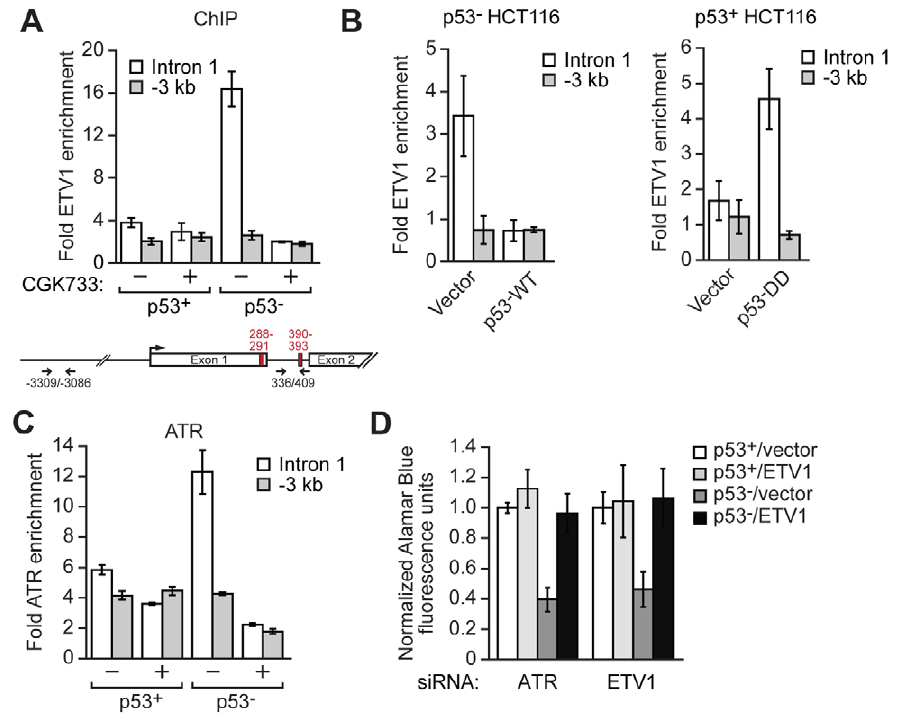
Figure 7. ATR and ETV1 are bound to the TERT promoter in p53 2 but not p53 + cells. (A) ChIP analysis monitoring ETV1 occupancy at two regions of the TERT promoter, in the first intron or 3 kb upstream of the transcription start-site, in p53 + and p53 2 HCT116 cells treated in the presence or absence of CGK733. The locations of the primer pairs (arrows) and ETV1-binding sites (red rectangles) are shown in the schematic of the TERT promoter (bottom). Error bars represent SD. (B) ChIP analysis monitoring ETV1 occupancy at two regions of the TERT promoter in p53 2 HCT116 cells expressing wild type p53 (p53-WT) or a vector control (left) and in p53 + HCT116 cells expressing a dominant negative p53 mutant (p53-DD) or a vector control (right). Error bars represent SD. (C) ChIP analysis monitoring ATR occupancy at two regions of the TERT promoter in p53 + and p53 2 HCT116 cells treated in the presence or absence of CGK733. Error bars represent SD. (D) Proliferation of p53 + and p53 2 HCT116 cells stably expressing ETV1 or, as a control, empty vector was determined by an Alamar Blue fluorescence assay. Proliferation was normalized to that obtained using a LMNA siRNA, which was set to 1 (not shown). Error bars represent SD.